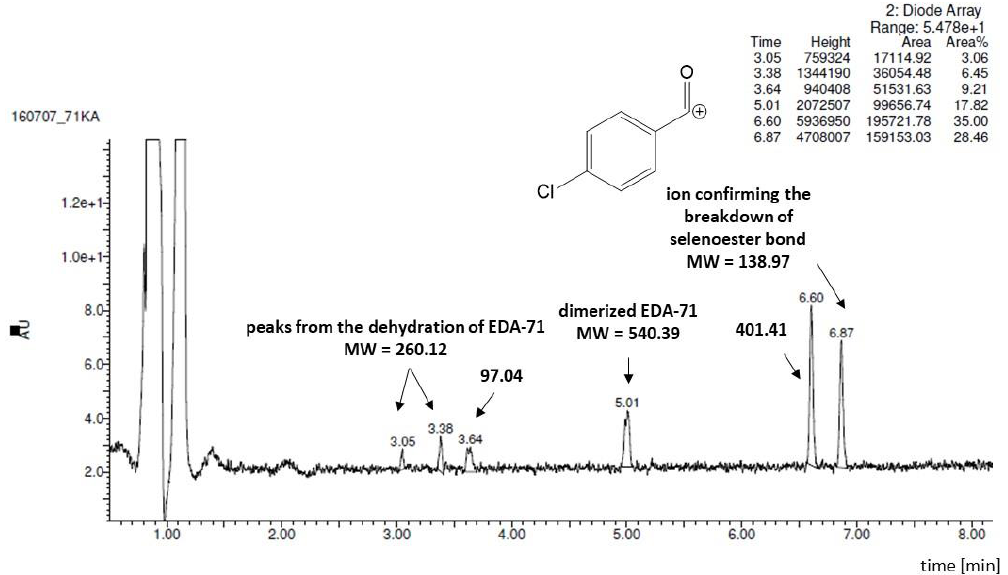
Figure 4. Stability of EDA-71 in TRIS buffer (pH = 7.4) and LC – MS/MS ionization conditions. Degradation compounds whose mass ranged from m / z = 97.04 to m / z = 540.39 were observed, and a maternal compound peak ( EDA-71 , m / z = 276.60) was not found. Potential degradation compounds observed: dehydration product with m / z = 260.12; dimer product with m / z = 540.39; and ion confirming the breakdown of selenoester bond ( m / z = 138.97).